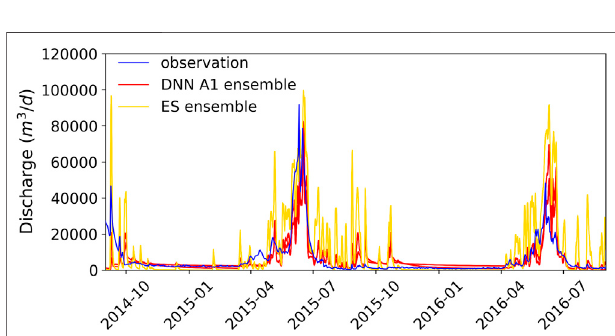
FIGURE 11 | Comparison between the observed discharge and the predicted discharge from ATS using the estimated permeability values from the DNN A1 and ES,